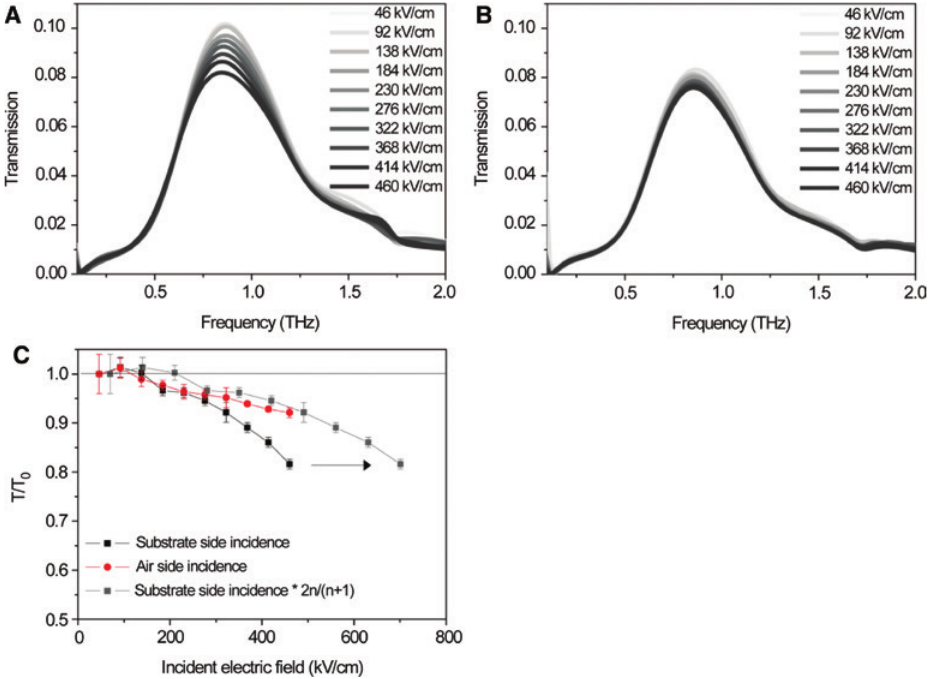
O -filled nanogap for (A) substrate-side incidences and (B) air-side incidences. (C) 2 3